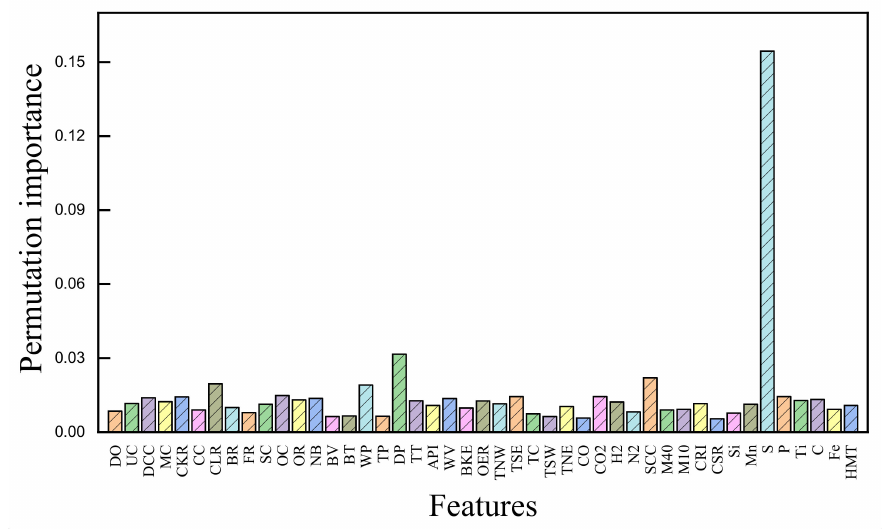
Figure 6. Importance of each parameter in the